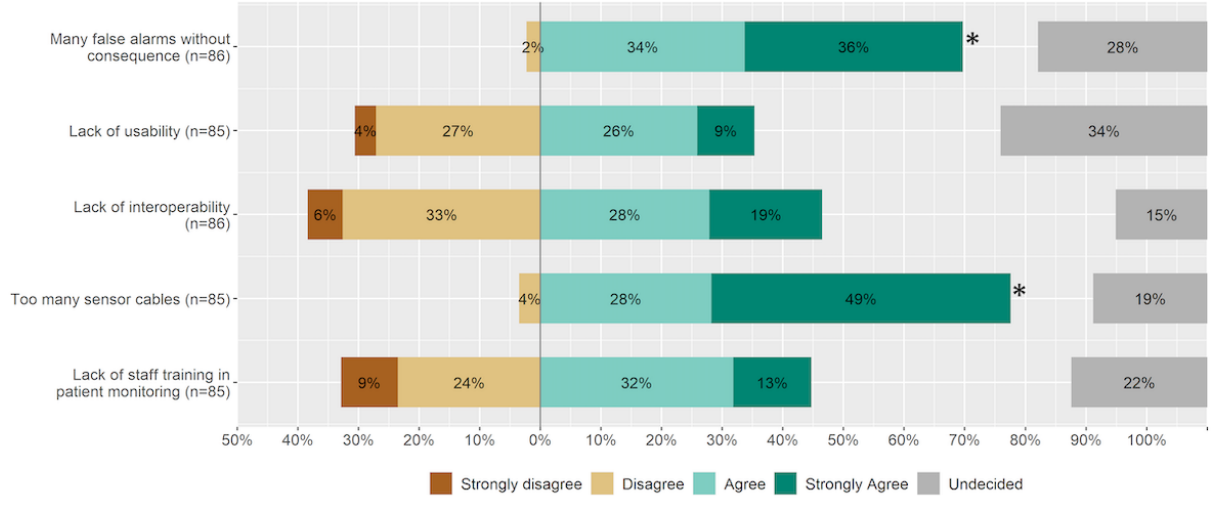
Figure 2. Aspects of patient monitoring disturbing patient care in the ICU. An asterisk indicates statistical significance. ICU: intensive care unit.